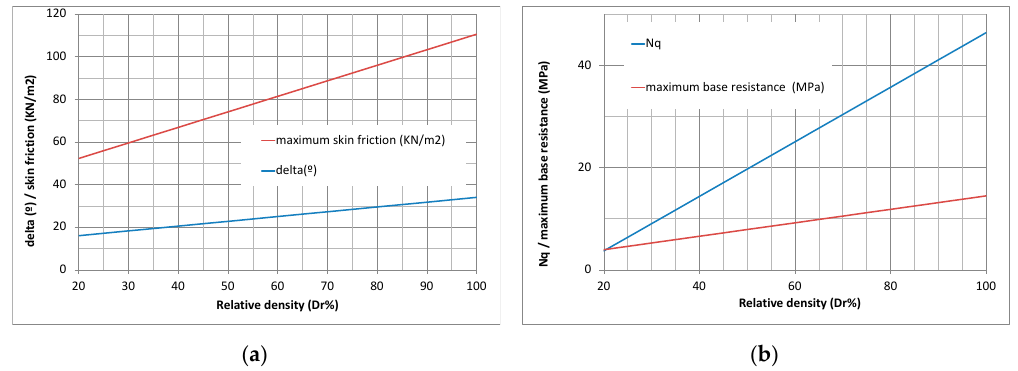
Figure 6. Pile bering capacity unitary resistances ( a ) Relationship between relative density and skin friction; ( b ) relationship between relative density and resistance.